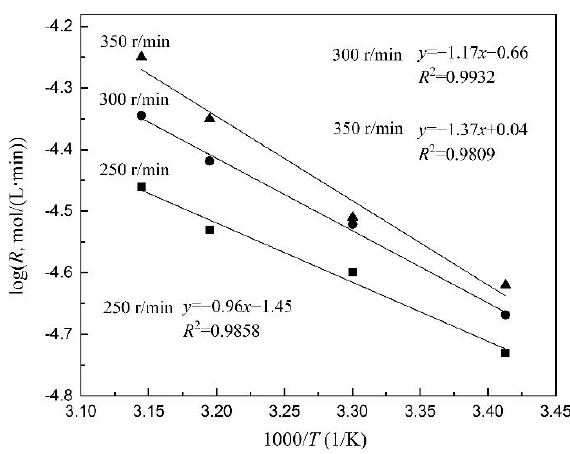
Figure 3. Effect of temperature on the stripping rate (experimental conditions: HEH/EHP concen- tration 0.2 mol/L, Ce 4+ concentration in organic phase 0.02 mol/L, HCl concentration in stripping agent 6.0 mol/L, c (H 2 O 2 ) (a) : c (Ce) (o) 2:1, and stirring speed 250 r/min, 300 r/min, 350 r/min).